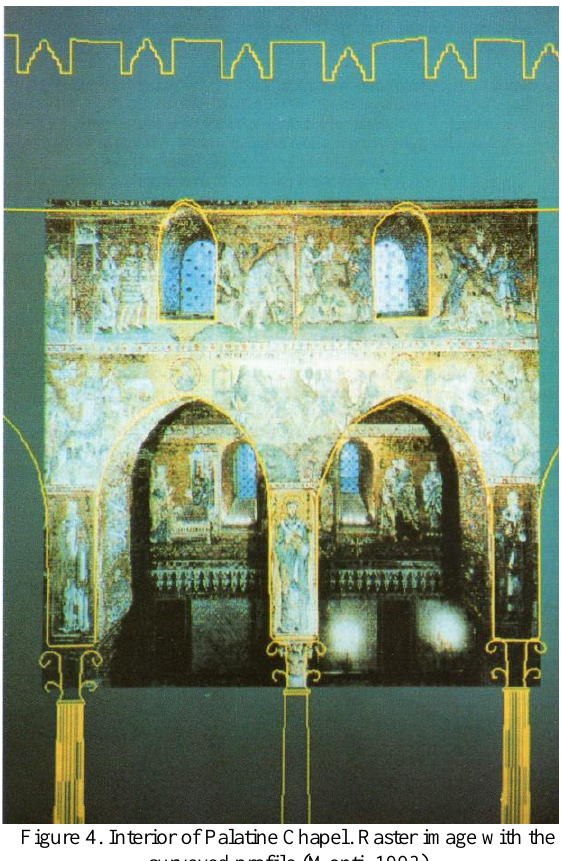
Figure 6. Restauration works in the Pisana Tower in Palermo by Francesco Valenti (Lucchese, 2012)